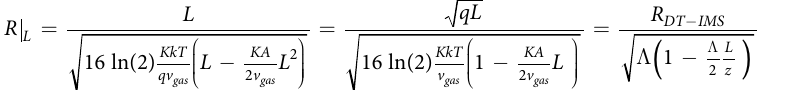
(cid:31)(cid:30) = E = − ∂ lines) and b) constant slope A = 2.5 e 5 and ion mobility = ⋅ − K m Vs 1 10 / 6 2 (8 nm) (solid lines). For case a) the initial condition is set at z = 2.4 cm as the slope A would be too high to maintain a constant separation ratio Λ for smaller values of z. Values that are off axis up to 1.1 cm still reach the end of the tube. In case b), the separation ratio Λ increases with the distance z progressively reducing the velocity of the moving ions ( v m = v gas − v drift ) until